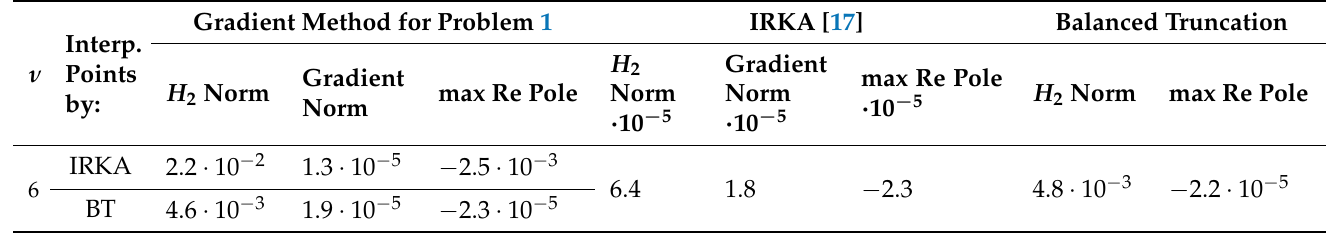
Table 2. Comparison of the gradient method-based solution of Problem 1 with algorithm (31) vrs. IRKA and balanced truncation, with the interpolation points chosen as the mirror images of the poles of the IRKA and BT models,